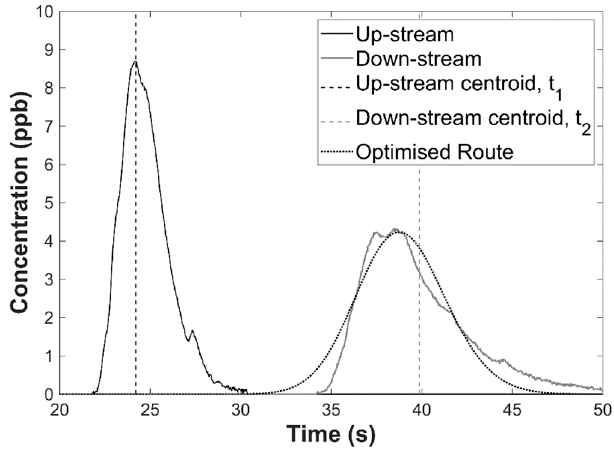
Figure 5. Example (Case A, fill level 3) of an up- and down-stream tracer concentration profile with a predicted down-stream profile using Equation (3) with optimized values of t (Travel Time) and D xx (Longitudinal Dispersion Coefficient).